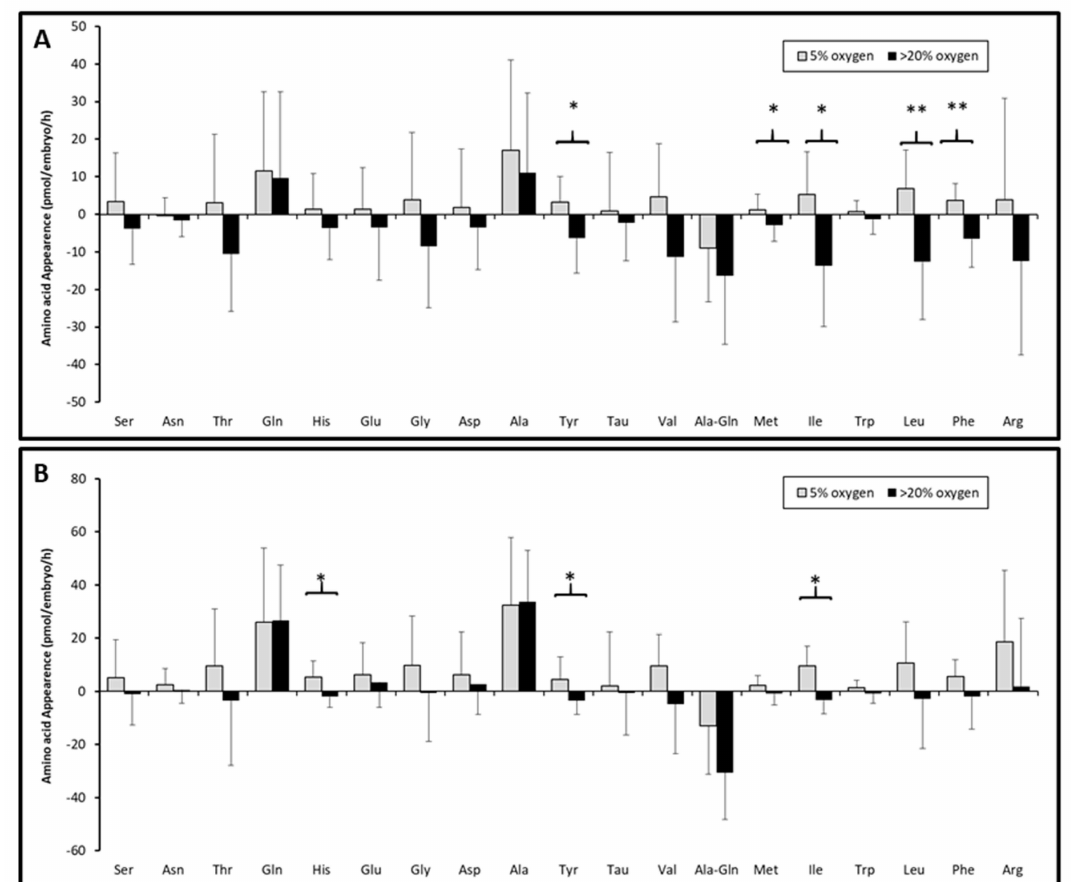
Figure 3. The bar chart showing the metabolic turnover of 17 amino acids, Tau and Ala-Gln in progressively developing embryos ( A ) and arrested embryos ( B ) cultured under the atmosphere containing either 20 oxygen ( n = 61) or 5% oxygen ( n = 67) for 24 h after vitrification. The error bars represent standard deviation. Asterisks show levels of statistical significance analyzed by ANOVA, p < 0.05; *, p < 0.01;